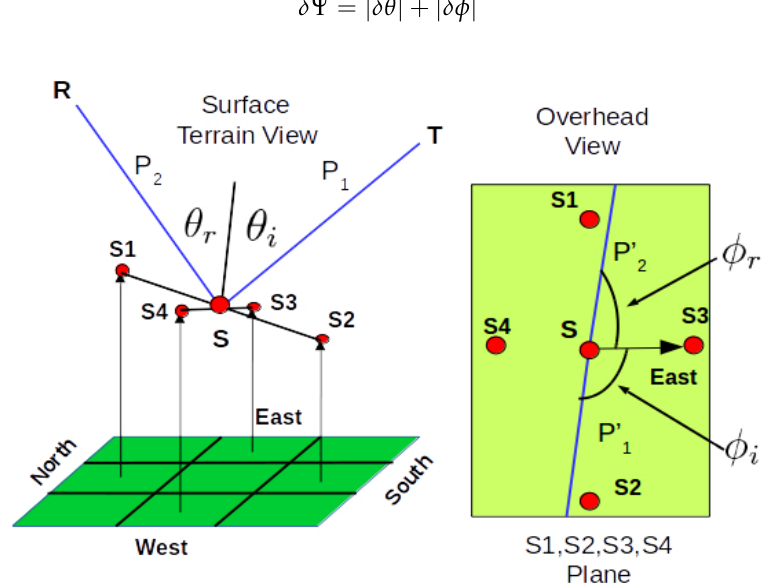
Figure 1. ( left ) Surface terrain view of point on local surface grid showing incident and reflection angles with respect to the surface normal. ( right ) Overhead view with incident and reflected vectors projected to a local two dimensional surface with forward scattering azimuth angles